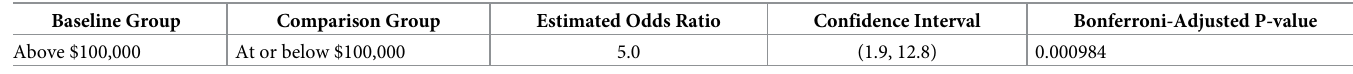
Table 6. Tests of differences by income, King County, Washington anti-SARS-CoV-2 seroprevalence survey, August 2020. Baseline